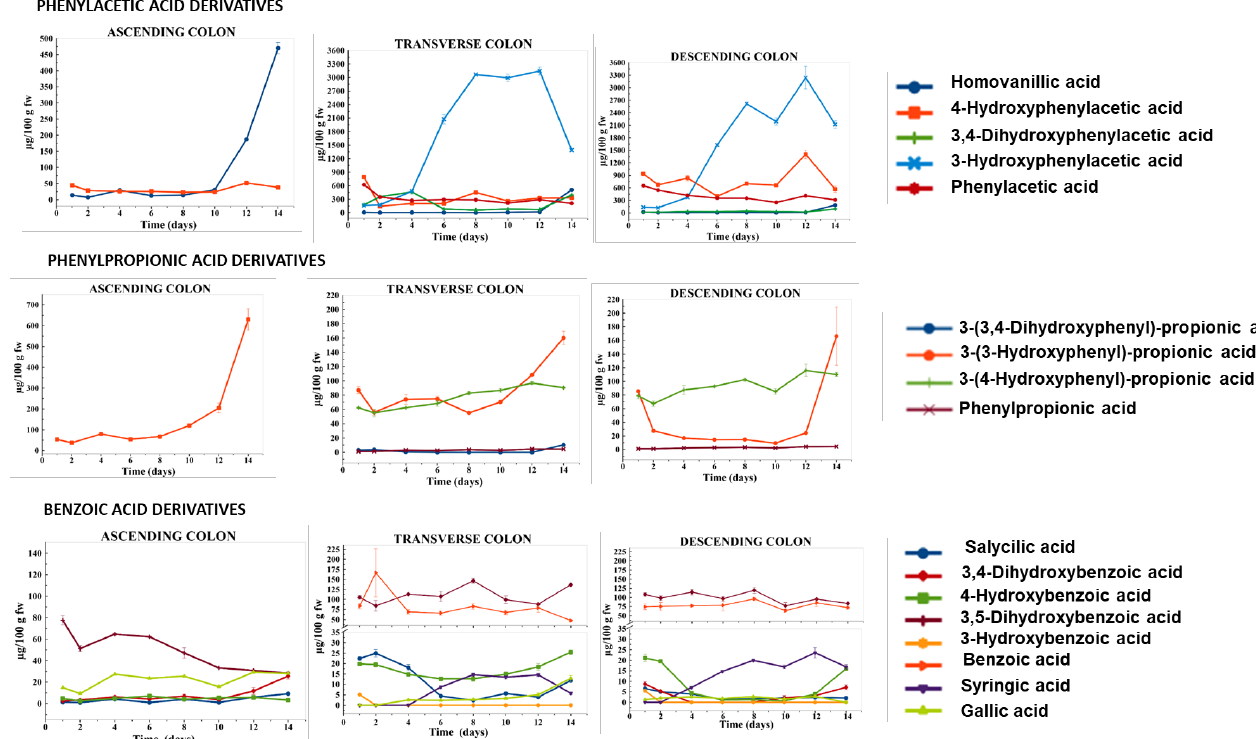
Figure 2. Concentration (µg/100 g fw of slurry) of phenylacetic, phenylpropionic, and benzoic acid derivatives, in the ascending colon (AC), transverse colon (TC), and descending colon (DC) during the colonic fermentation of HPP-treated onion powder. Data are the mean values ± standard deviation of three different determinations ( n = 3).